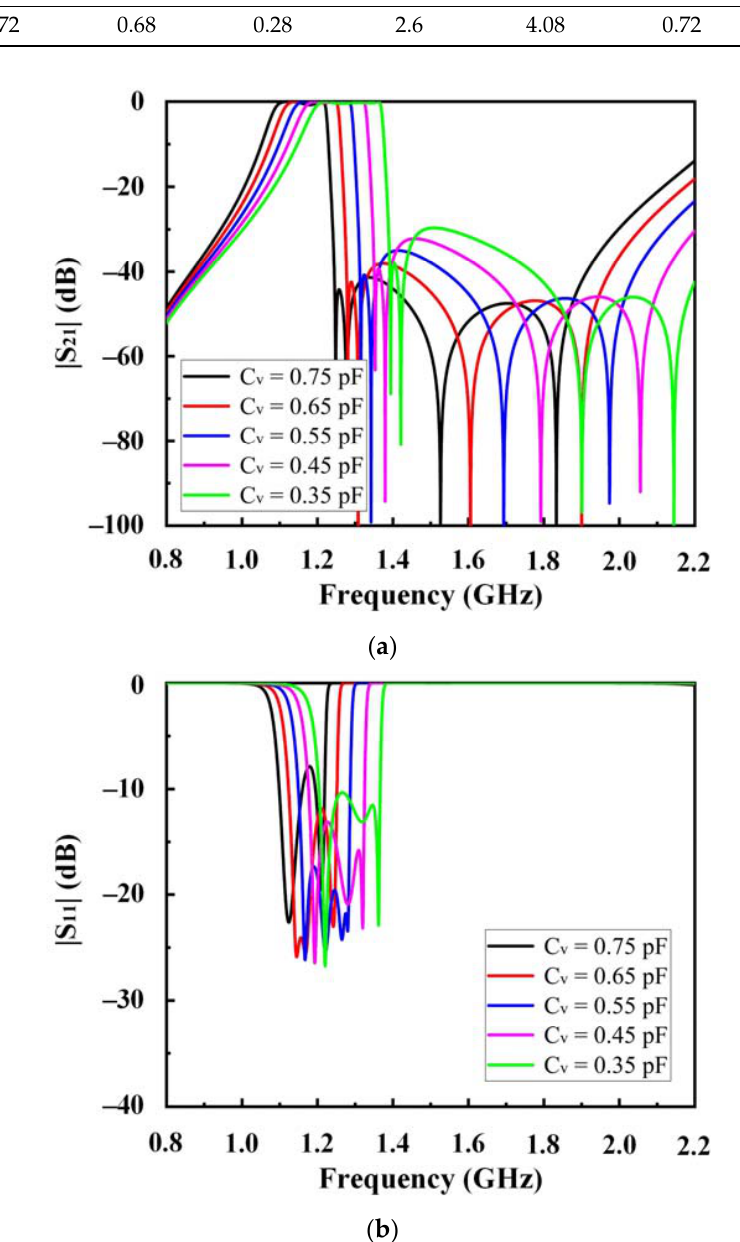
Figure 7. Simulated. ( a ) S 21 ; ( b ) S 11 of the four-pole HTS-tunable filter .